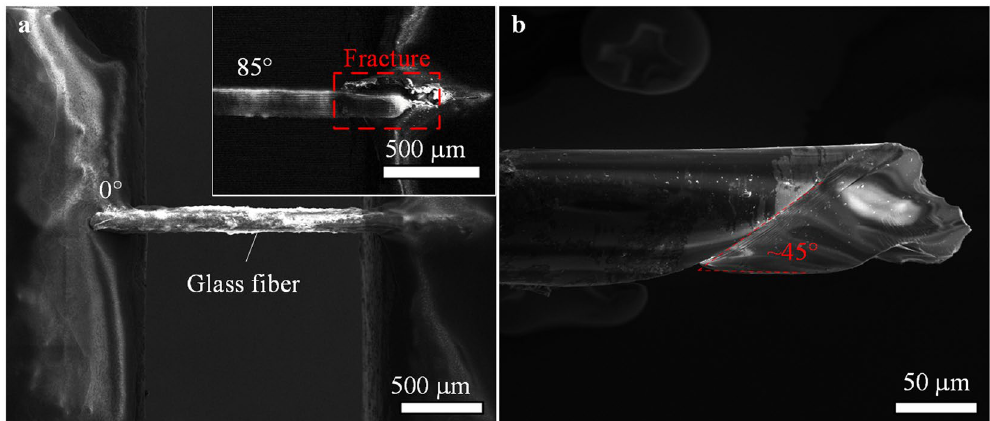
Figure 4. Twisting test of glass fiber. ( a ) The glass fiber is assembled on the two sample holders of iTRo with gauge length approximate 1000 μ m, and it is fractured at twisting angle 85°. ( b ) Fracture image indicates that it is a typical brittle failure caused by tensile